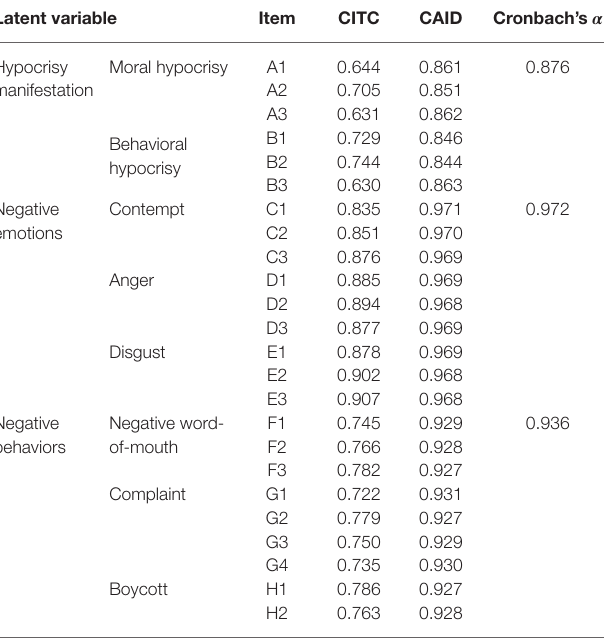
TABLE 2 | Results of reliability analysis. TABLE 3 | Normalized factor loading, average variance extracted (AVE), and composite reliability.